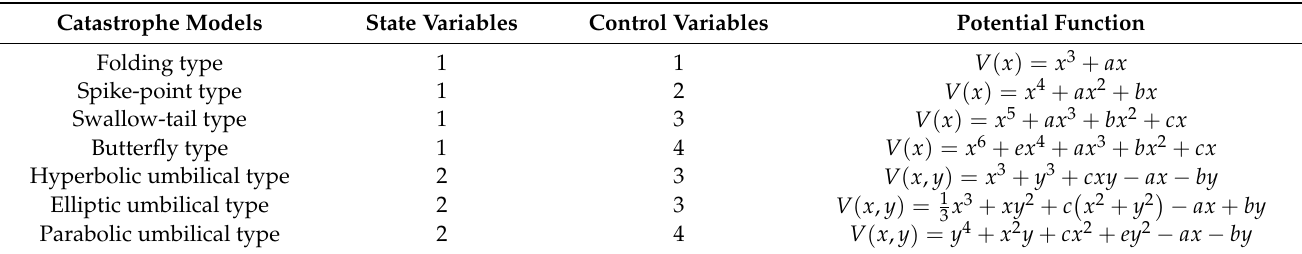
Table 1. Common catastrophe models and normalization